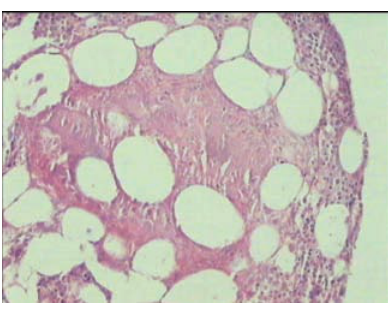
Figure 3. Bone marrow trephine biopsy showing granuloma (x100, Hematoxyline